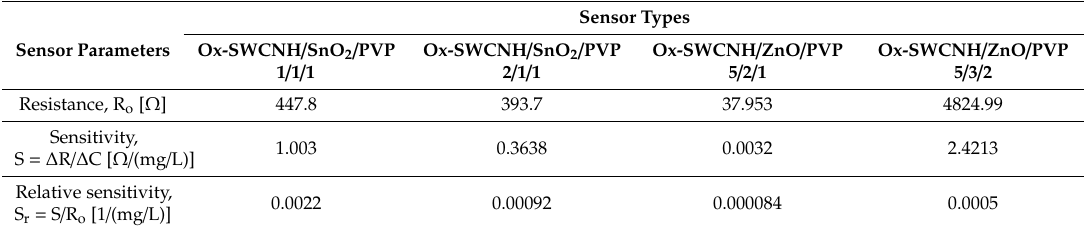
Table 1. Comparison of sensitivities ( ∆ R / ∆ C) and relative sensitivities ( ∆ R / ∆ C) / R o for di ff erent types of “ternary” sensors presented in this